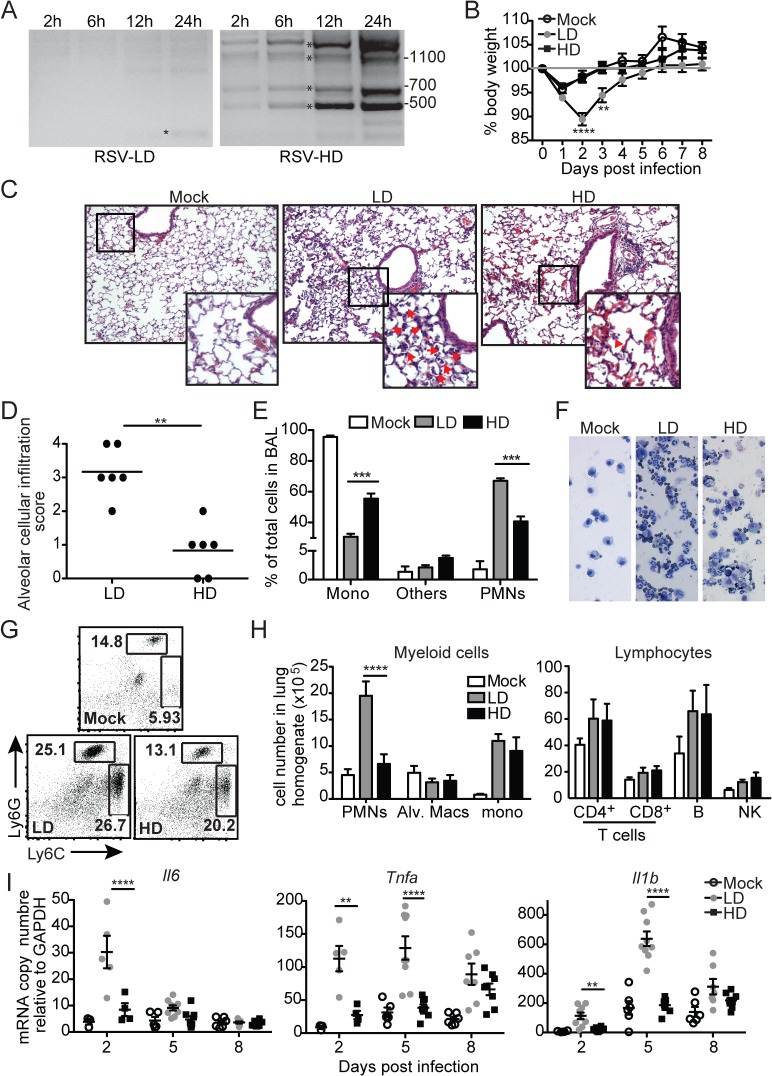
RSV DVGs prevent viral pathogenesis in vivo.(A) Hep2 cells were infected with RSV-LD or HD at a moi of 1.5 TCID50/cell and DVGs were detected by PCR at the indicated times. Details of the PCR assay can be seen in S1 Fig and sequences of the amplicons labeled with a star can be found in S2 Fig Base pair size references are indicated in the gel. (B) Mice weight loss was monitored overtime. Error bars indicate standard deviation of data pooled from two independent experiments (n = 7–9 mice per group total; **p<0.01, ****p<0.0001 by two-way ANOVA with Bonferroni post hoc test. Variance was not significantly different between groups as per Bartlett’s test). (C) Representative H&E staining for lung sections from mock, RSV-LD, or RSV-HD-infected mice on day 2 post infection. Picture magnification: 10X; insert is a digital amplification. Red arrows indicate alveolar cellular infiltrate. (D) Pathology score for alveolar infiltration in the lung (n = 6 mice per group; **p<0.01, by two-tailed Mann Whitney test). (E) Differential counts from cytospins from mice bronchoalveolar lavage (BAL) on day 2 post infection (Mono: monocytes and macrophages, PMNs: polymorphonuclear cells; ***p<0.001 by two-way ANOVA with Bonferroni’s post hoc test, n = 5–8 mice per group). (F) Representative cytospin images (20X). (G) Representative flow cytometry plots from whole lung single cell suspensions on day 2 post infection. Plots are pre-gated in singlets, live, CD45+CD11b+ cells. (H) Quantification of different cell types in the lung of infected mice on day 2 post infection (****p<0.0001 by two-way ANOVA with Bonferroni’s post hoc test, n = 5–8 mice per group, Alv. Macs: alveolar macrophages). (I) Expression of pro-inflammatory genes in whole lung tissue on day 2, 5, and 8 post infection. (n = 3–5 mice per group, *p<0.05, **p<0.01 by one-way ANOVA with Bonferroni’s post hoc test).